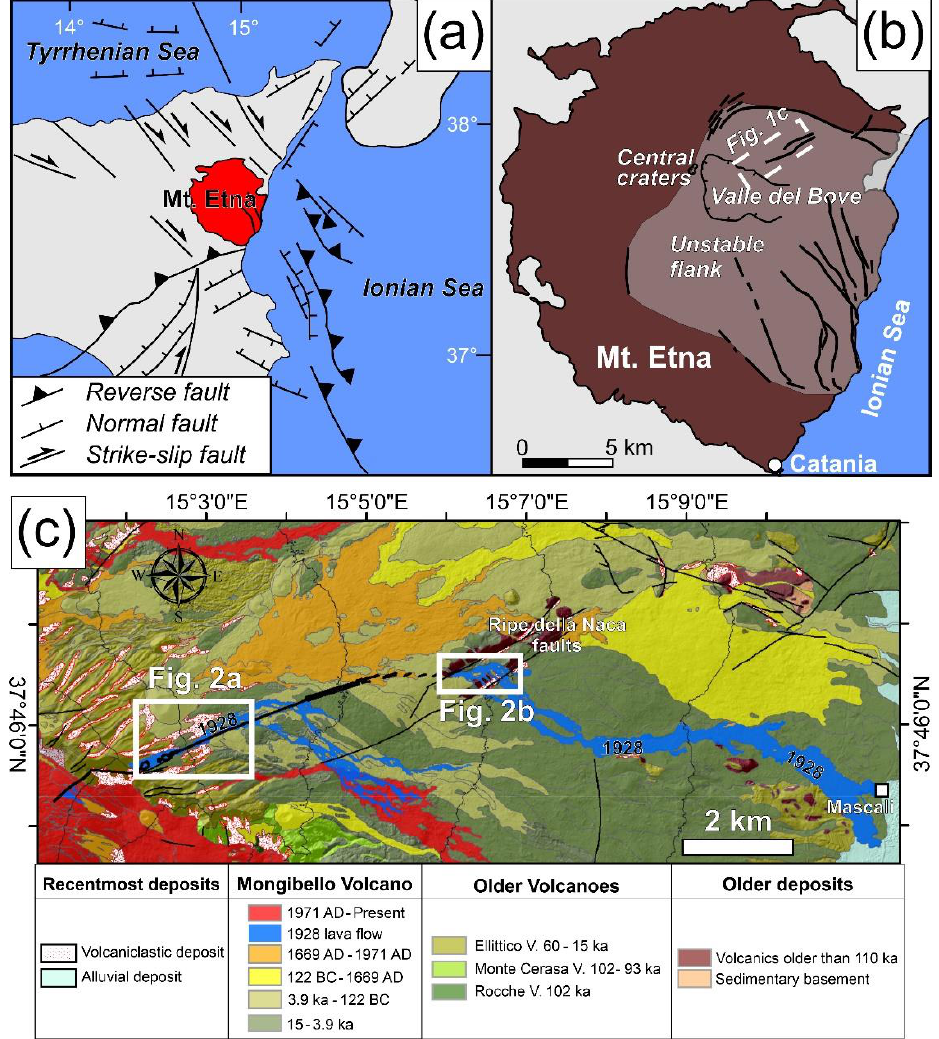
Figure 1. ( a ) Map showing the geodynamic setting. ( b ) Map showing the main structures of Mt. Etna, with the eastern flank characterized by instability (a and b modified after Villani et al. [34]). ( c ) The geological map of the eastern flank is shown here, modified from Branca et al. [35]; the deposits related to the 1928 eruption are indicated in blue, and the location of Mascali village is also shown; the most recent and older deposits and older volcanoes are also